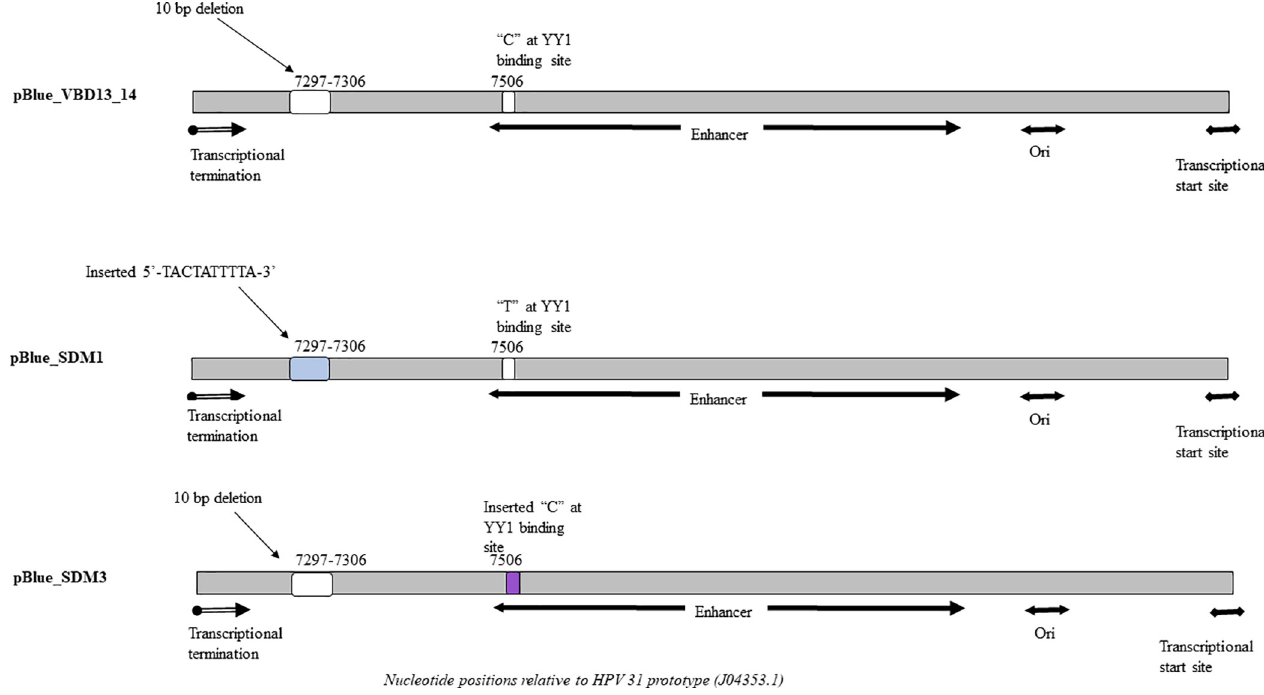
Fig 1. Schematic representation of the full-length LCR variants cloned upstream of the β -galactosidase gene in the reporter vector pBlue-Topo 1 . YY1 binding site, Yin-Yang 1 binding site; Enhancer, keratinocyte-specific enhancer domain; Ori, origin of replication of the HPV31 circular genome.